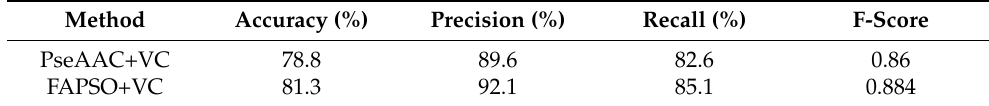
Table 7. GPCR classification performance for sub-subfamily level.